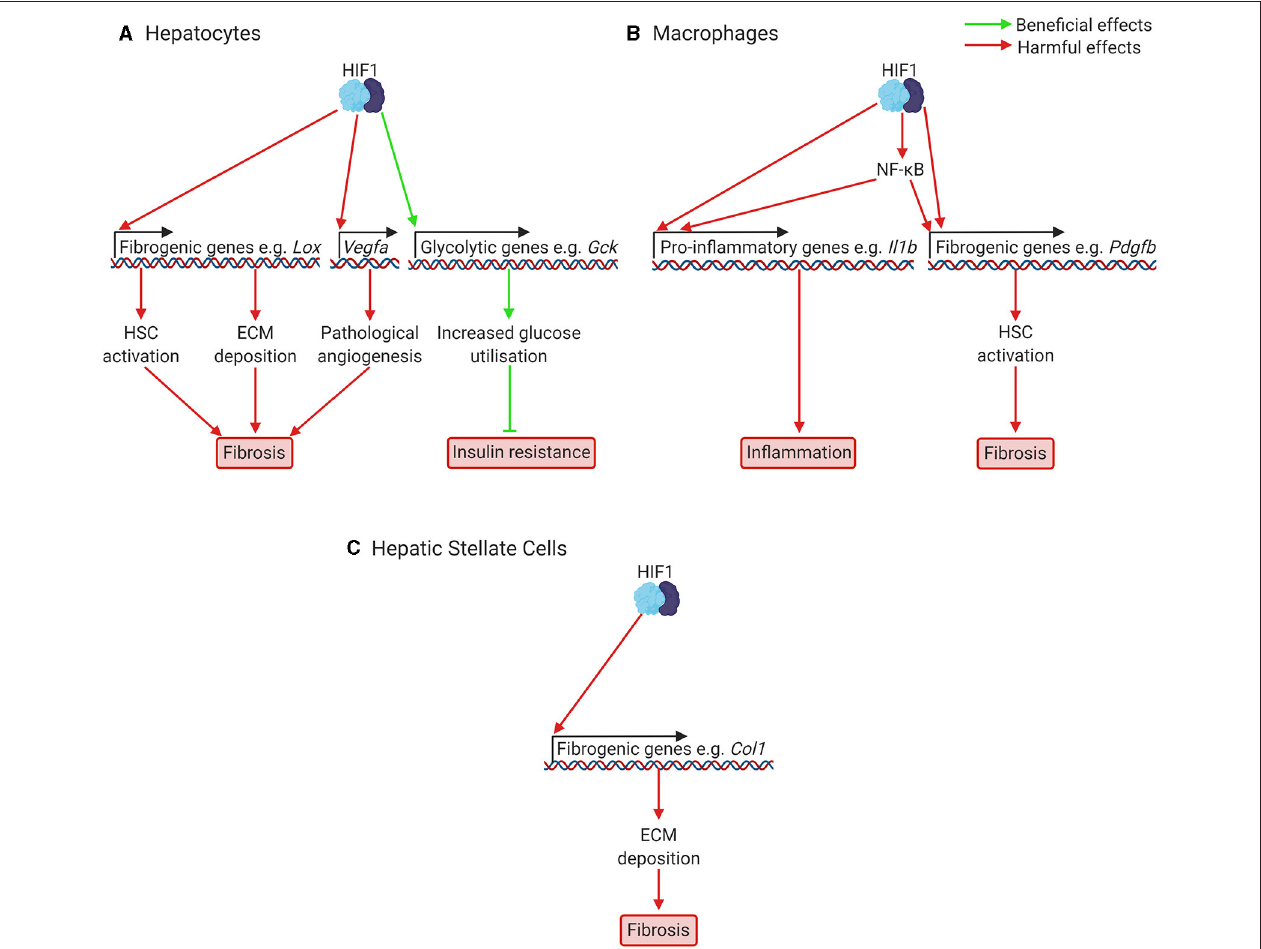
FIGURE 3 | Putatively beneficial and harmful effects of HIF1 activation in NAFLD and NASH. (A) In hepatocytes, HIF1 activation leads to increased expression of fibrogenic genes, including genes responsible for HSC activation (e.g., Pdgfb), ECM deposition (e.g., Lox), and pathological angiogenesis (Vegfa). Pathological angiogenesis has only been investigated in fibrosis models, not NAFLD models. HIF activation also increases expression of glycolytic genes such as glucokinase and glucose transporters, which increases glucose consumption and improves glucose handling. This can help prevent insulin resistance. (B) In macrophages, including resident macrophages in the liver, Kupffer cells, HIF1 activation increases expression of pro-inflammatory cytokines such as Il1b, leading to inflammation, and of fibrogenic genes, such as the HSC activator Pdgfb, leading to fibrosis. HIF1 also appears to activate NF- κ B, a key regulator of fibrosis and inflammation. (C) In HSCs, which will be activated at increased levels due to signals from other cells resulting from HIF1 activation, HIF1 activation is also required for transcription of fibrogenic genes, such as Col1, encoding Type 1 Collagen. For many of these effects of HIF1 activation, the precise mechanisms are not yet clear and not all genes mentioned are necessarily under direct HIF1 control. Col1, Type 1 Collagen; Gck, glucokinase; ECM, extracellular matrix; HIF, hypoxia-inducible factor; HSC, hepatic stellate cell; Il1b, interleukin 1b; NF- κ B, nuclear factor kappa-light-chain-enhancer of activated B cells; Pdgfb, platelet derived growth factor b; Vegfa, vascular endothelial growth factor